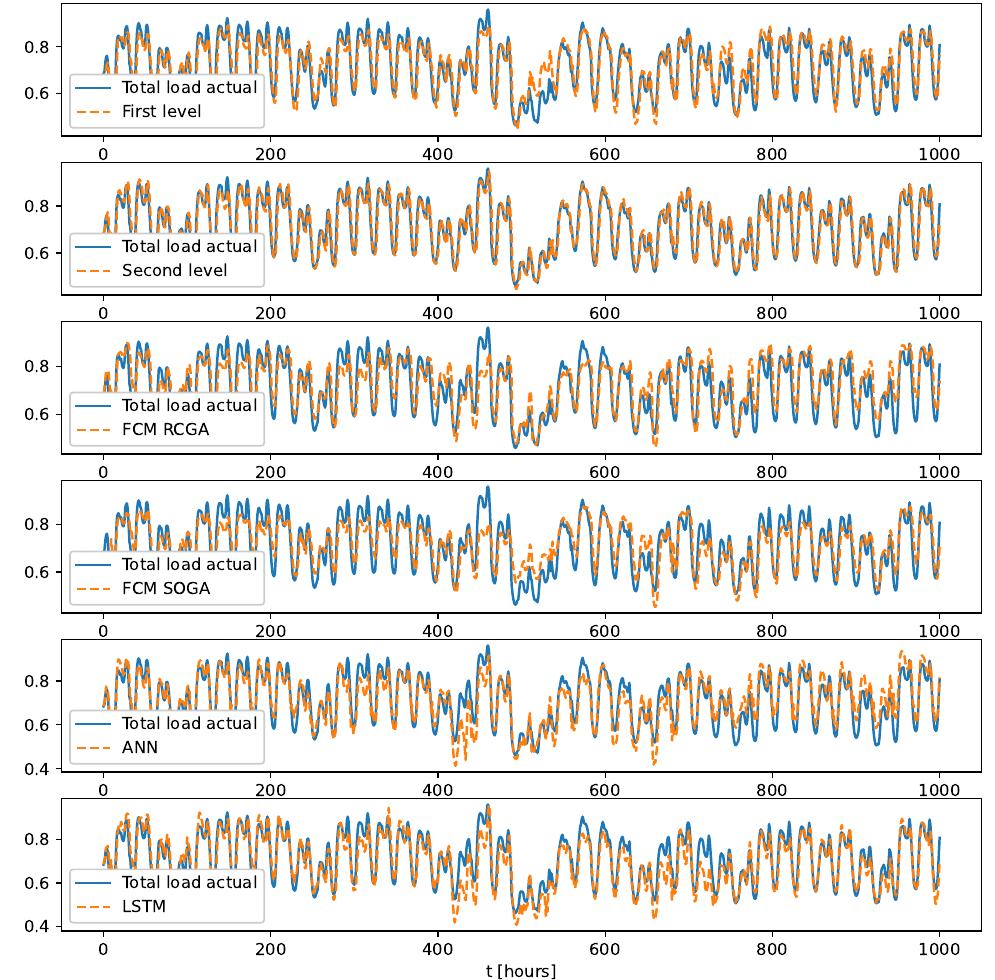
Figure 5. Forecasting results for the best model obtained with the use of the first and the second level of the nested structure, the FCM RCGA approach, the FCM SOGA approach, the ANN model and the LSTM